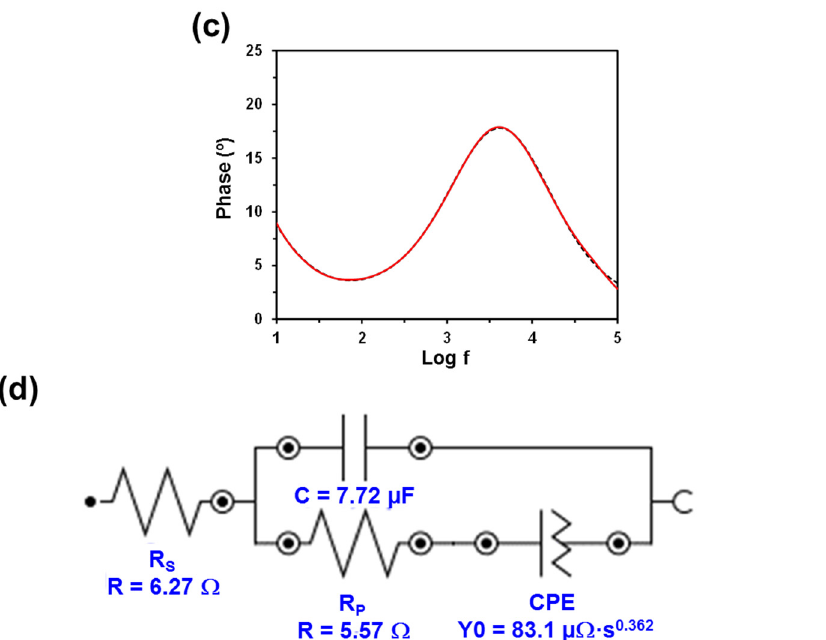
Figure 4. Measured and fitted EIS spectra (solid red line and dashed black line, respectively) for the CMC hydrogel sandwiched between two PEDOT electrodes: ( a ) Nyquist plot; ( b ) impedance Bode plot; and ( c ) phase Bode plot. ( d ) EEC model used for numerical fitting of the EIS data. Numerical results from fitting the spectra are displayed for all the elements of the EEC.